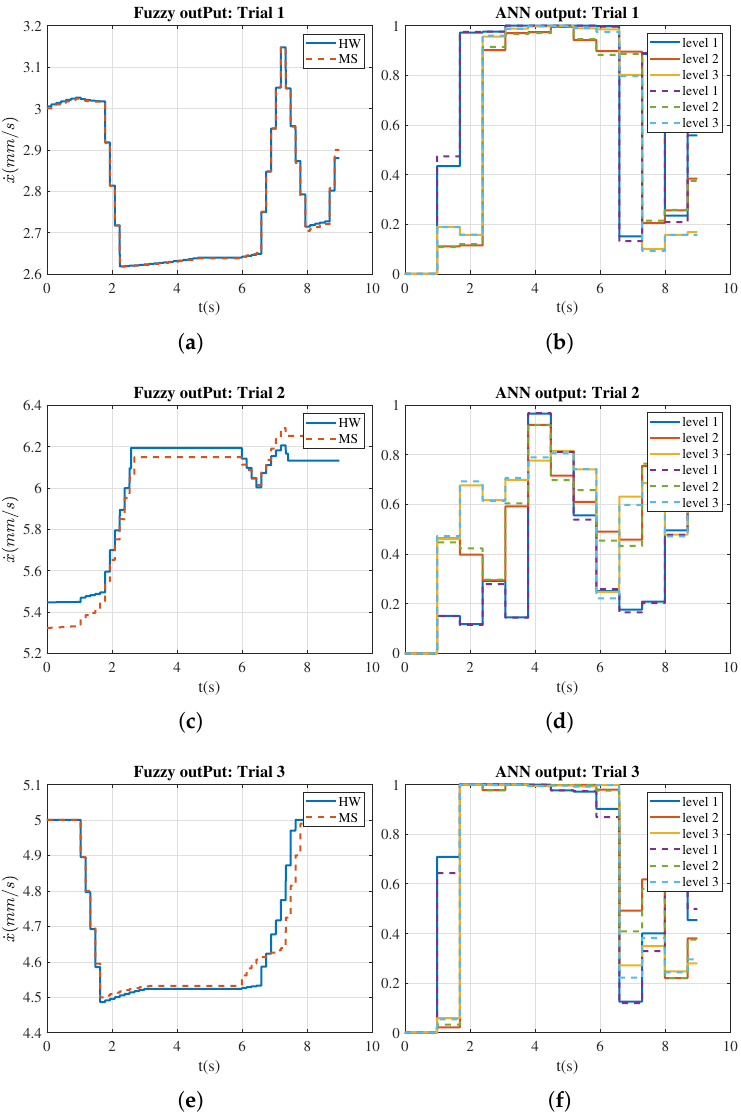
Figure 5. Velocity modulation ( a , c , e ) and membership degree to the 3 muscular levels ( b , d , f ). Simulation (MS, continuous line) and experimental (HW, dashed lines) were compared for each trial. During the tests reported in Figure 6, it was observed that the on-off controller had a higher activation during the experiments than with the simulation model. The additional activation was expected since the system depends on the real motor position feedback (moving average filter) and the serial communication, which presented delays. These variations cause the on-off control to turn on and off since the tracking error varies. The discontinuity of the actuator and the joint angular position were obtained by selecting the maximum value of the angular position difference between samples. The actuator has a step resolution of approximately 0.9 mm, with a mean value of 1 mm and a variance of 0.029 mm 2 . The angular discontinuity analysis (Table 3) shows that the DIP joint obtains the highest value with an average of 0.21 rad or 5.72 ◦ , while the MPC joint obtains the lowest value with an average of 0.04 rad or 2.29 ◦